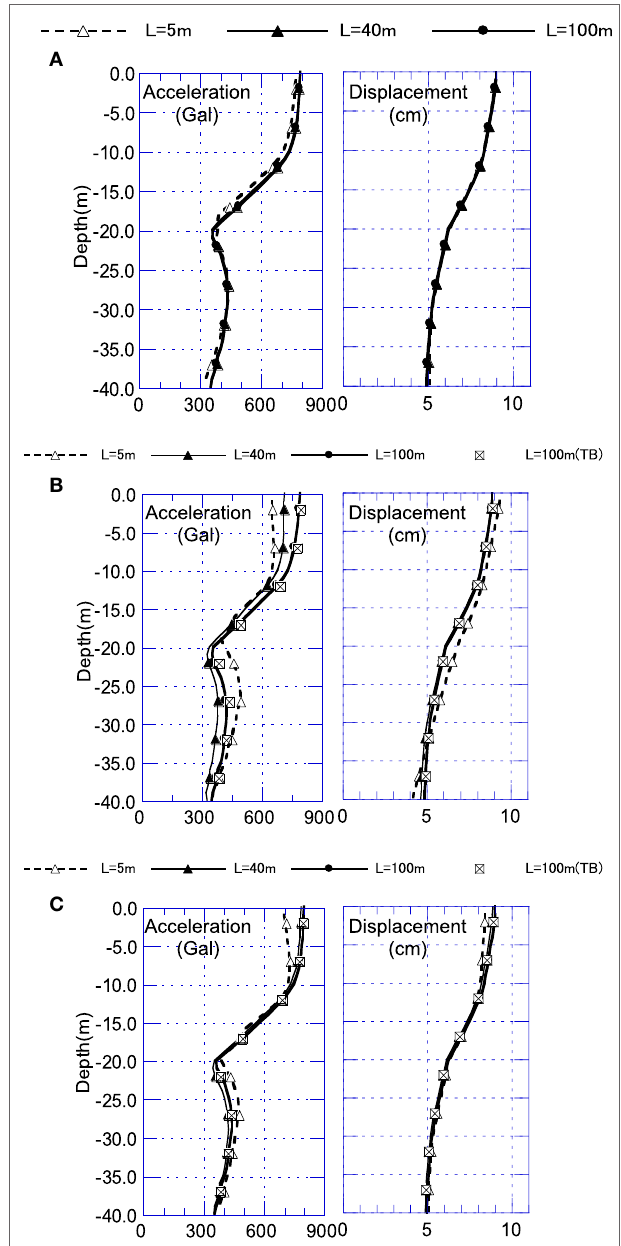
FigUre 13 | Maximum response of soil for X excitation . (a) TB. (B) VB without EF. (c) VB with EF.